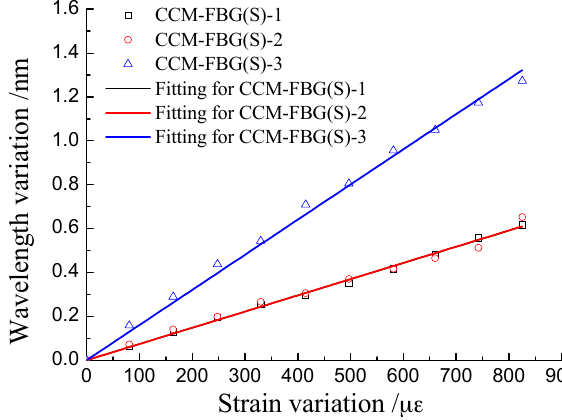
Figure 6. Calibration results of strain for CCM-FBG.